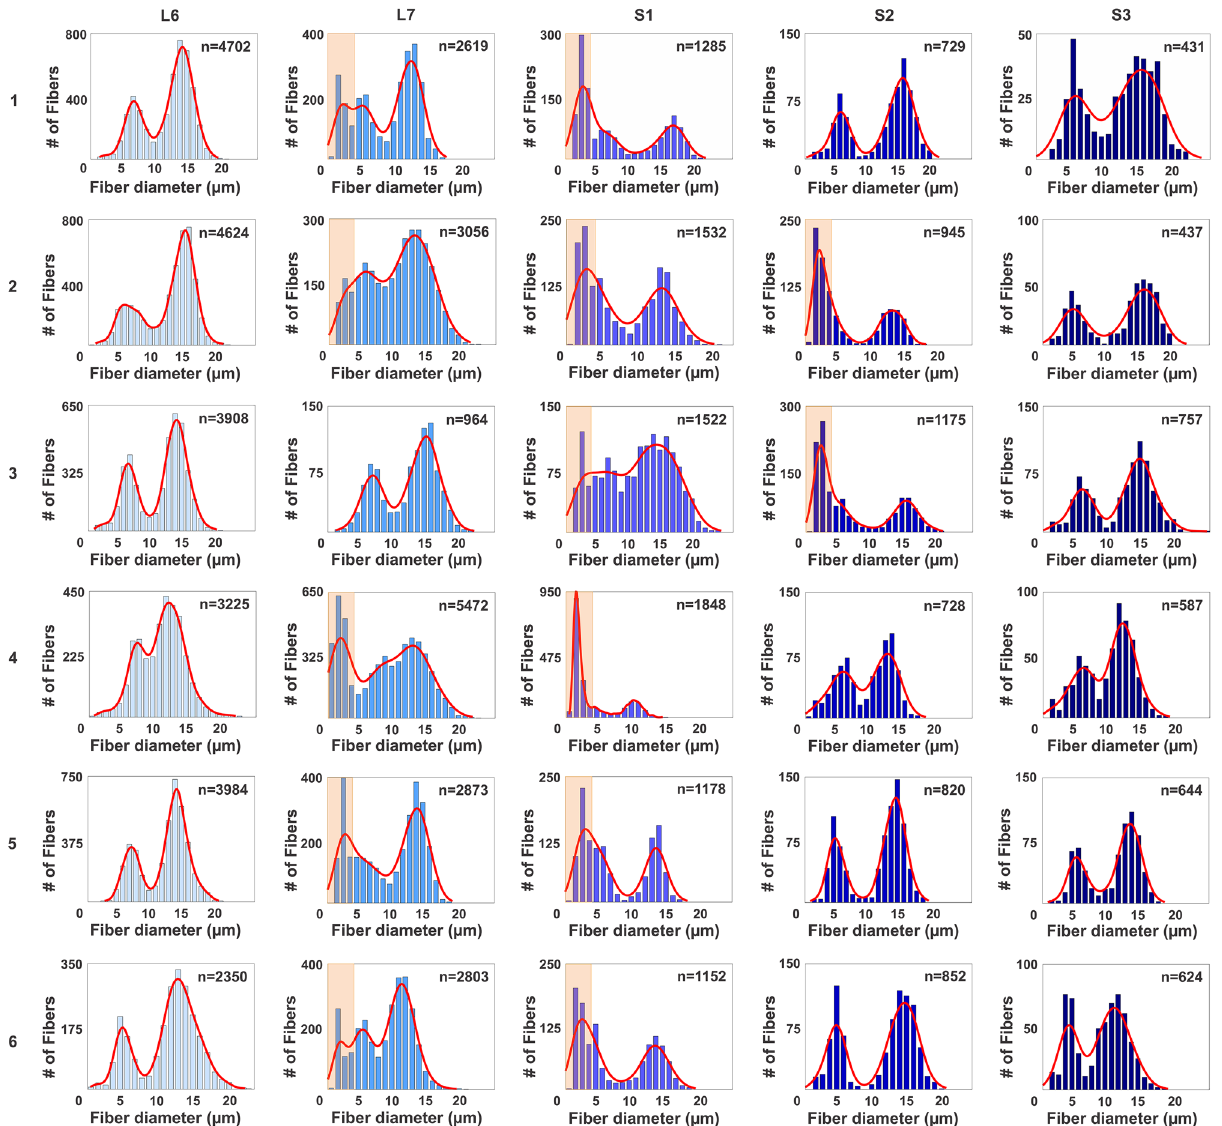
Figure 3. Myelinated fiber size and distribution across lumbosacral ventral roots (VRs) in rhesus macaques. Display of myelinated fiber size distribution for L6–S3 VRs in six female rhesus macaques. Note bimodal size distribution in all of the L6 and S3 VRs with size peaks corresponding to the large myelinated axons represented by γ- and α-motor fibers 21–23 . Within the L7–S2 VR span, all subjects show an additional peak in 2 or 3 consecutive roots of small-sized myelinated axons, highlighted by salmon-colored boxes for fibers within the 0–4 µm range. This population of fibers correspond to the small diameter of preganglionic parasympathetic fibers 24 . Note extensive individual variation for the rostro-caudal distribution of the autonomic fiber population with detection of this cohort of fibers predominantly in the L7 + S1 VRs (subjects 1, 4, 5, and 6), L7 + S1 + S2 VRs (subject 2), or S1 + S2 VRs (subject